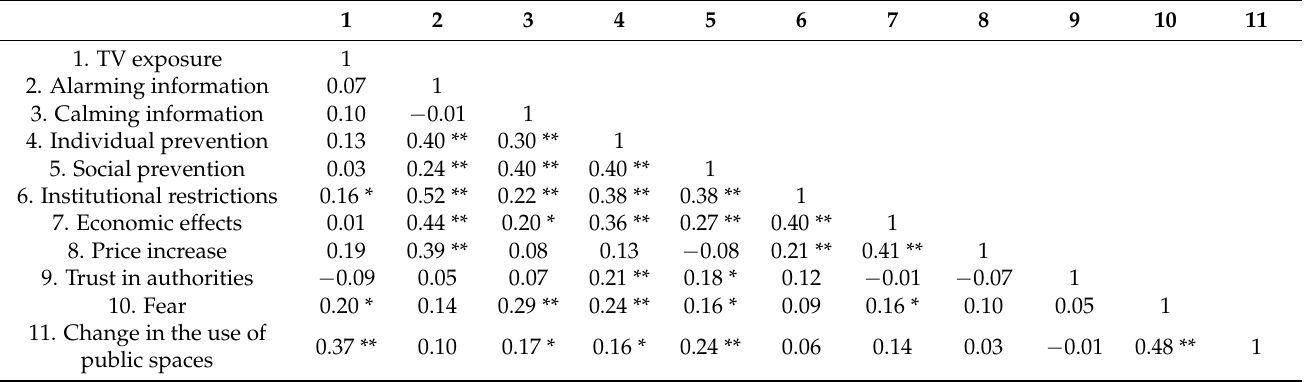
Table 1. Correlation analysis: TV exposure, people’s attitudes, emotions, and the use of public spaces.